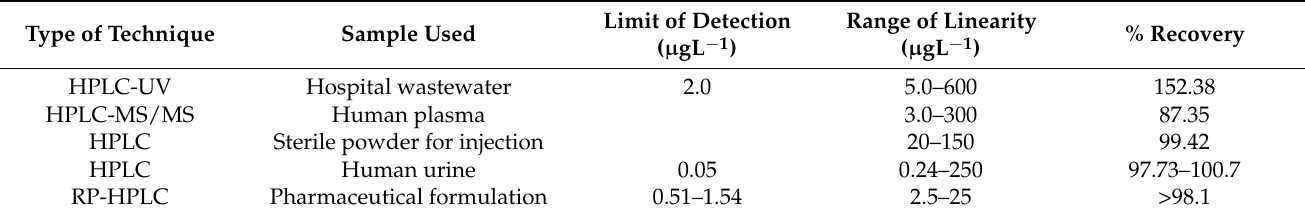
Table 2. Comparison of chromatographic methods used for determination of ceftriaxone